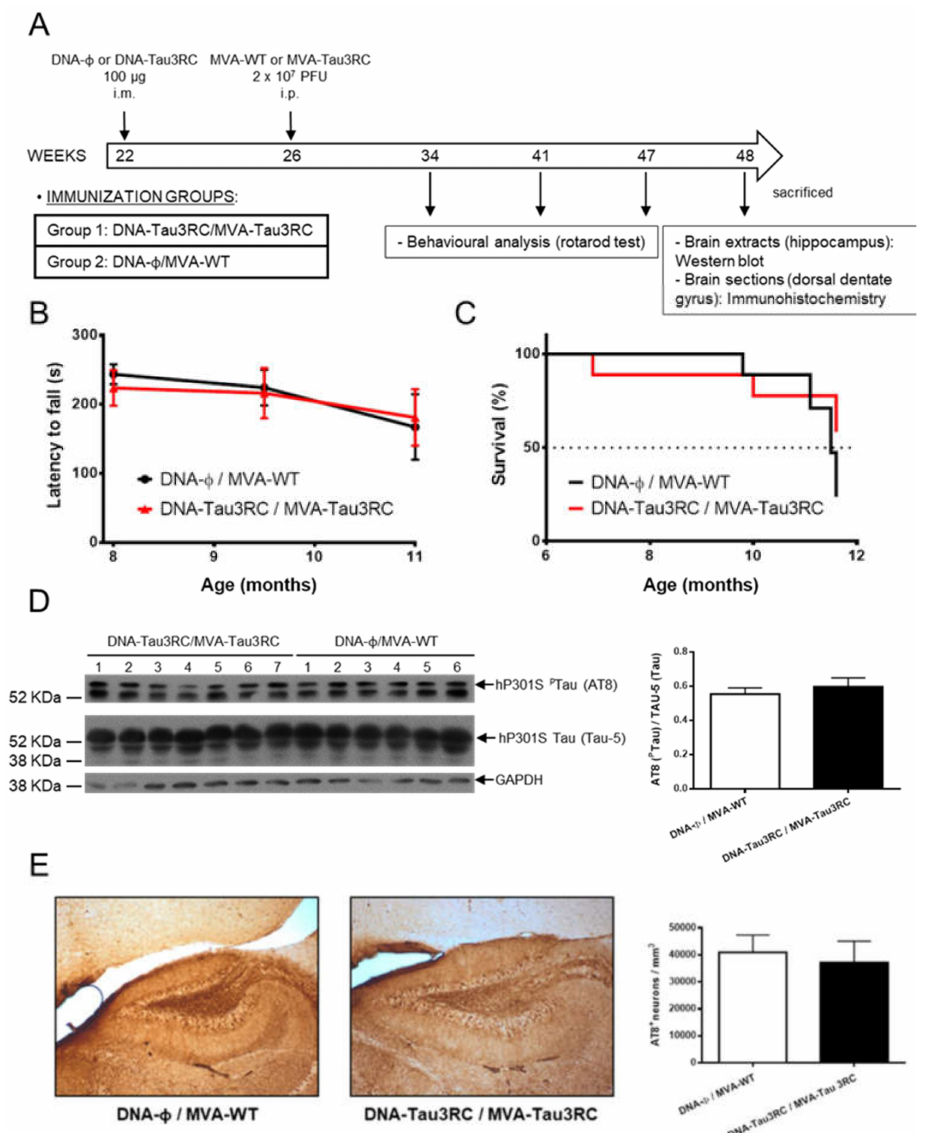
Figure 6. Studies on e ffi cacy of MVA-Tau3RC in transgenic P301S mice. ( A ) Vaccination scheme. Groups of transgenic P301S mice ( n = 6–7 mice / group, 22 weeks of age) were immunized with 100 µ g of DNA-Tau3RC (pSG5-Tau3RC) or DNA- Φ (pSG5) by the i.m. route. Four weeks later (week 26), animals were immunized with 2 × 10 7 PFUs of MVA-Tau3RC or MVA-WT by the i.p. route (see Materials and Methods). At weeks 34, 41, and 47 (months 8, 9.5 and 11, respectively) rotarod test were performed and animals were sacrificed at week 48. ( B ) Rotarod performance evolution. The latency to fall (in seconds) in P301S animals immunized with DNA-Tau3RC / MVA-Tau3C or DNA- Φ / MVA-WT was evaluated by a rotarod test at months 8, 9.5 and 11. The mean and SD are represented. ( C ) Survival rate. The percentage of P301S mice immunized with DNA-Tau3RC / MVA-Tau3C or DNA- Φ / MVA-WT surviving during the length of the experiment is represented, after the booster inoculation at week